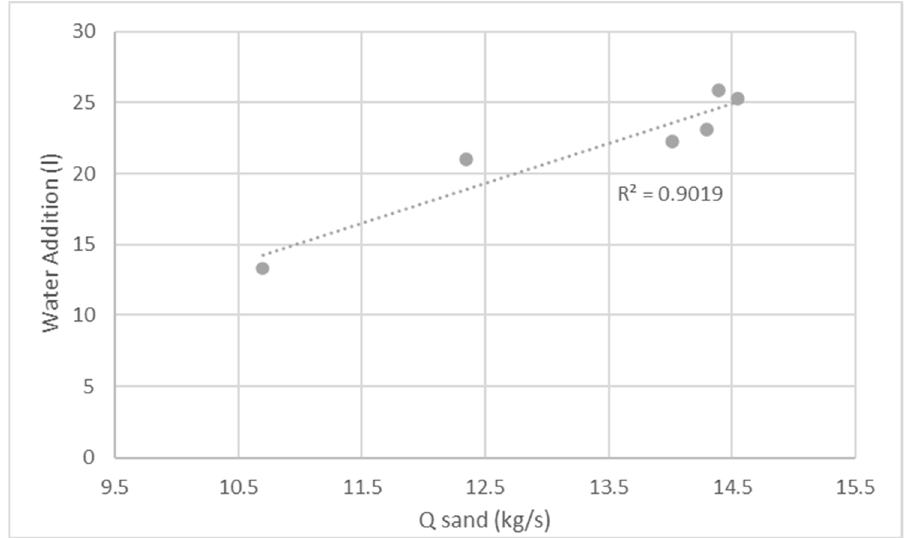
Figure 5. Relationship between the flow of sand with respect to the addition of water when the outlet temperature of the sand is 60 °C.